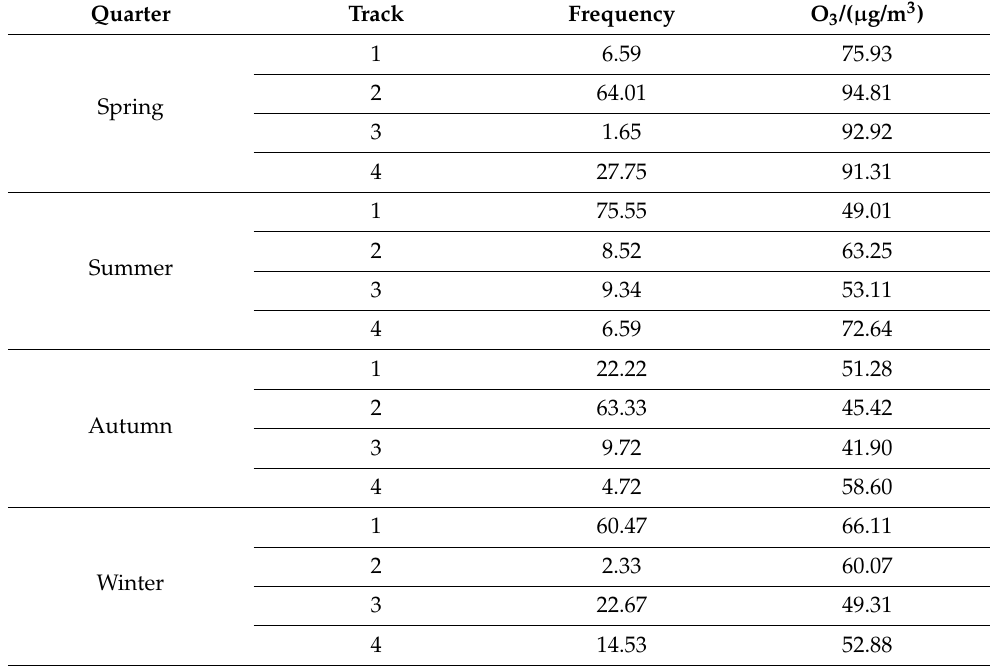
Table 4. Clustering results of backward trajectories and corresponding average concentrations of O 3 in four seasons of Baoshan city in